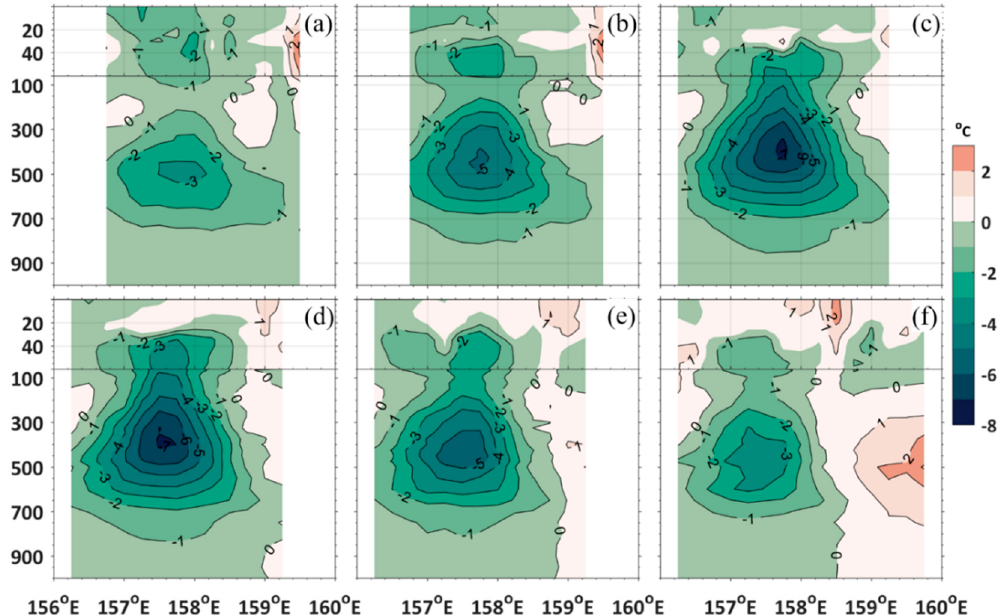
Figure 2. Temperature anomalies at the six sections. ( a ), ( b ), ( c ), ( d ), ( e ) and ( f ) are for the sections of S1, S2, S3, S4, S5 and S6,